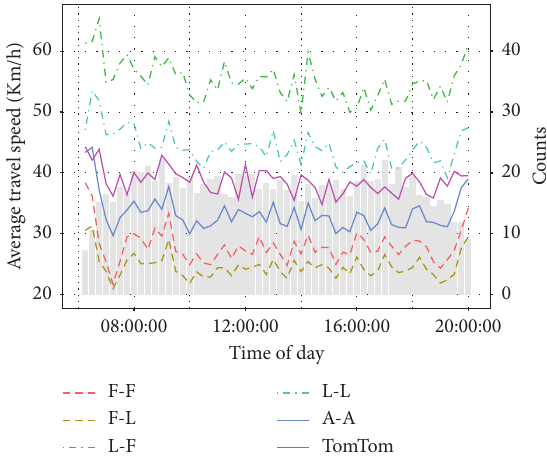
Figure 11: The comparison of five BTaverage speeds and TomTom average speed of link 43-896.